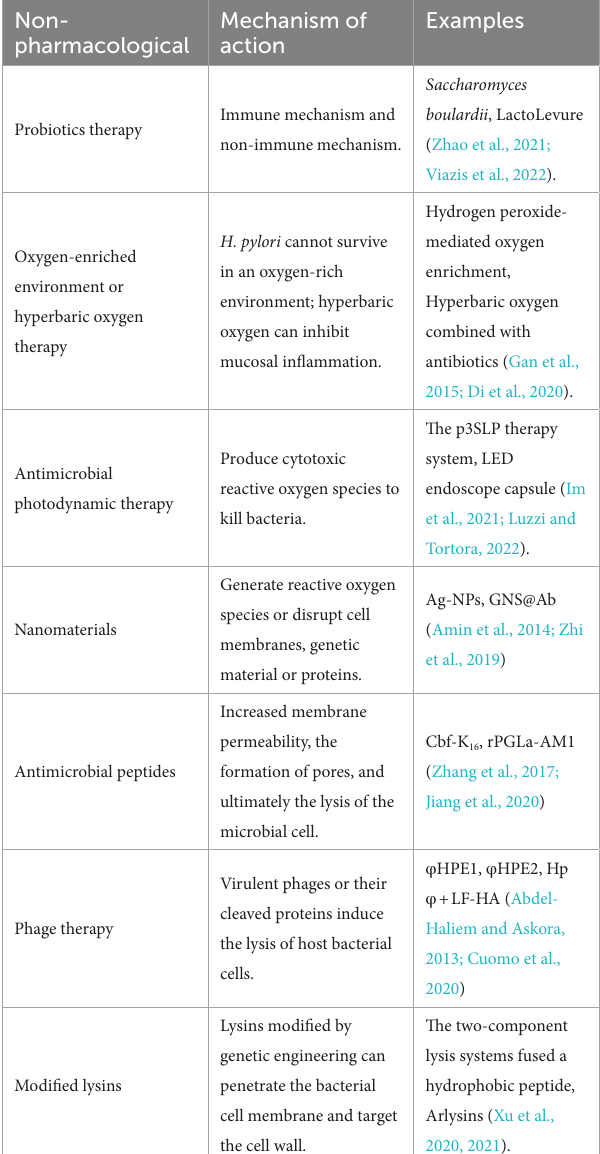
TABLE 1 Non-pharmacological therapy of Helicobacter